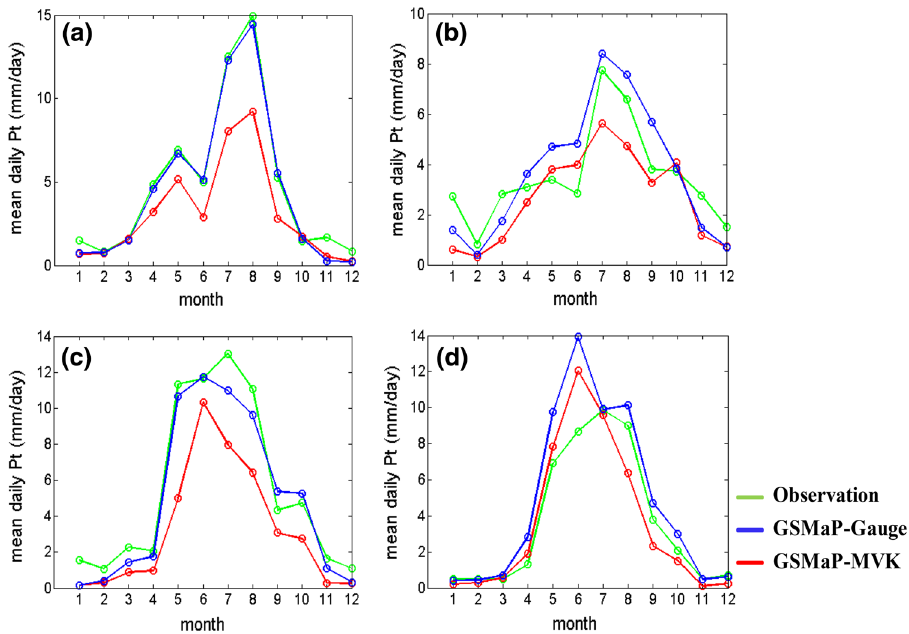
Fig. 4 Seasonal Variation in basin average precipitation of GSMaP-MVK (red line) and GSMaP-Gauge (blue line) vs ground measurements (green line) in a Hyeonsan basin, b Fuji basin, c Da basin, and d Upper-Cau basin